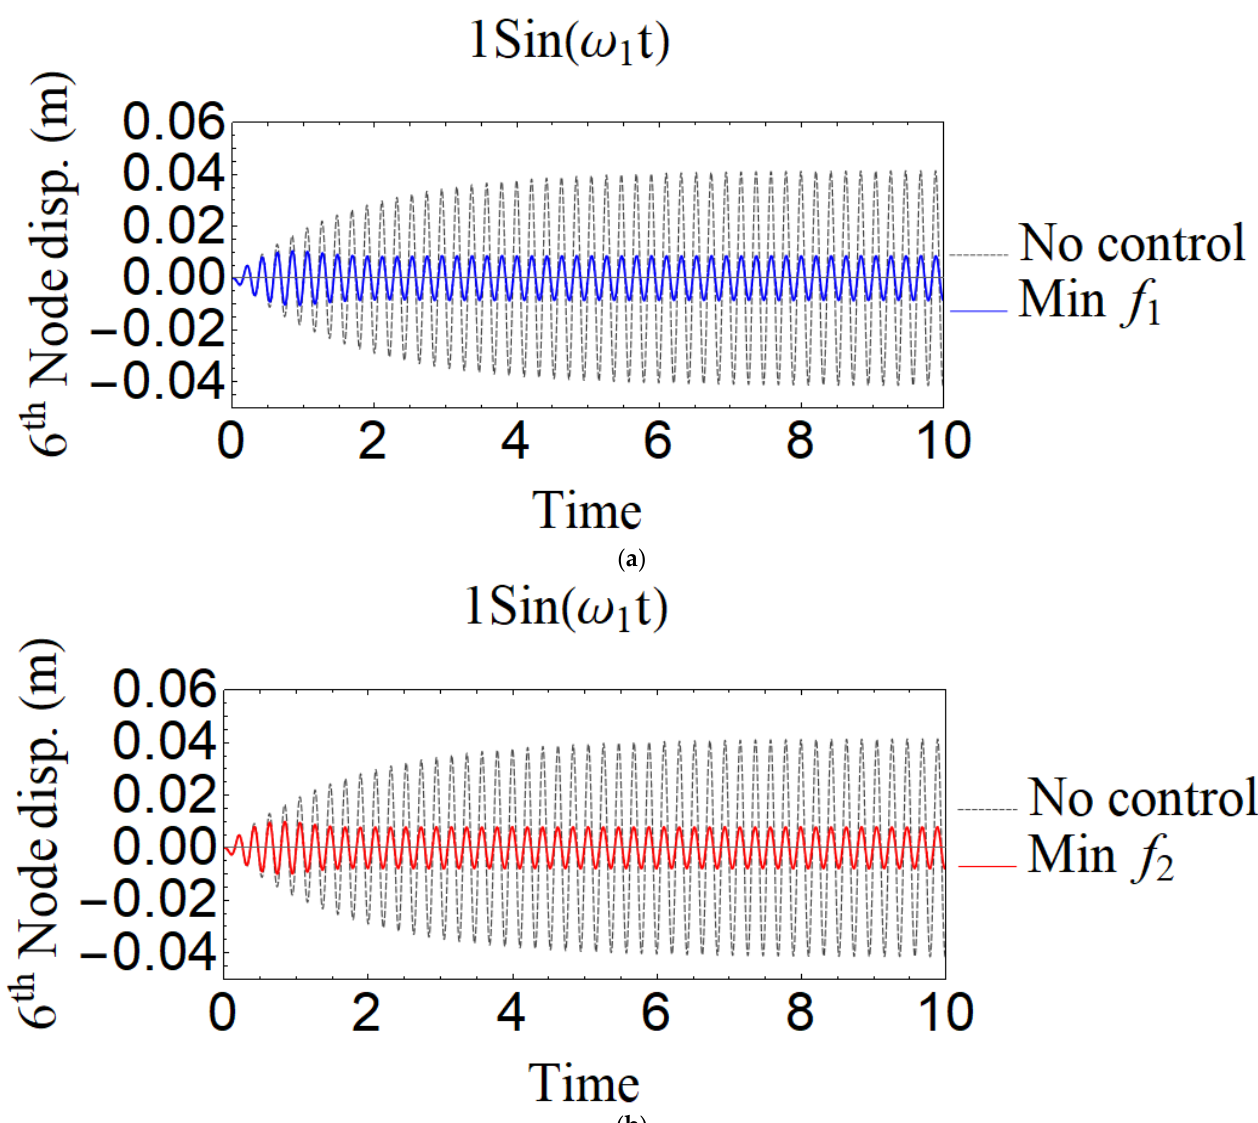
Figure 7. Time history response of the vertical displacement of the 6th node of the cantilever beam under the first mode harmonic base excitation considering ( a ) 𝑓 (cid:2869) and ( b ) 𝑓 (cid:2870) objective functions.